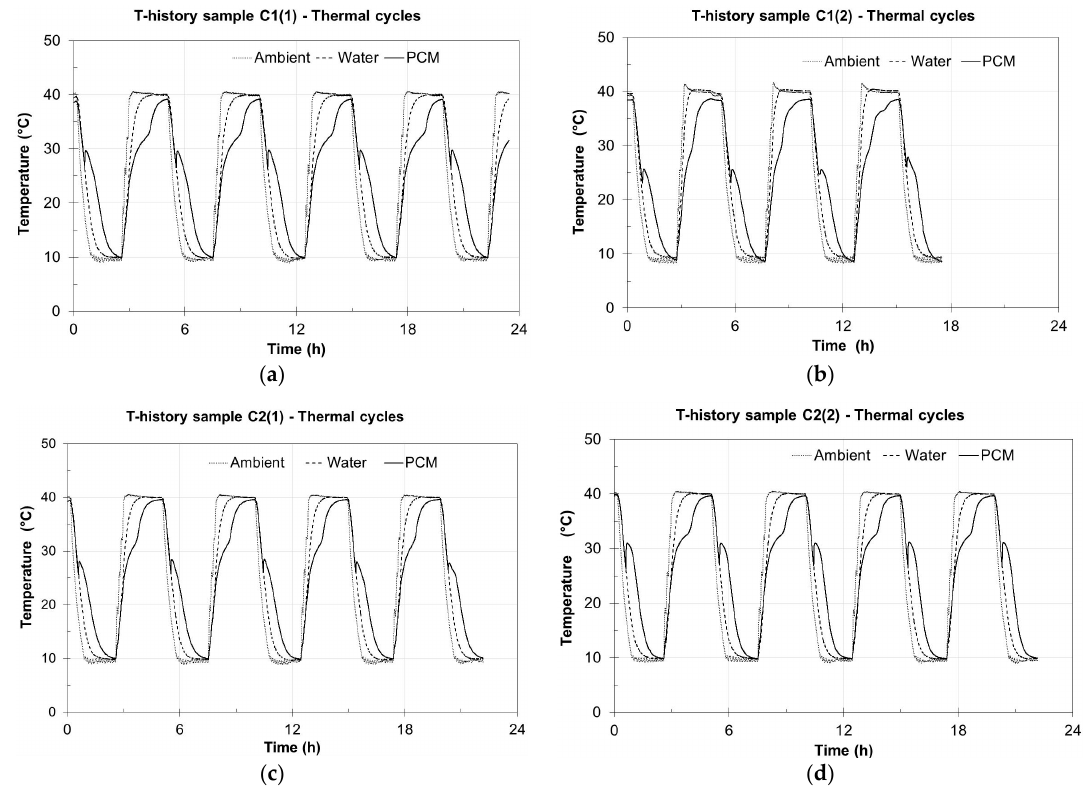
Figure 2. Heating and cooling cycles for all the samples, during the T-history method. ( a ): Sample C1(1); ( b ): sample C1(2); ( c ): sample C2(1); and ( d ): sample C2(2).